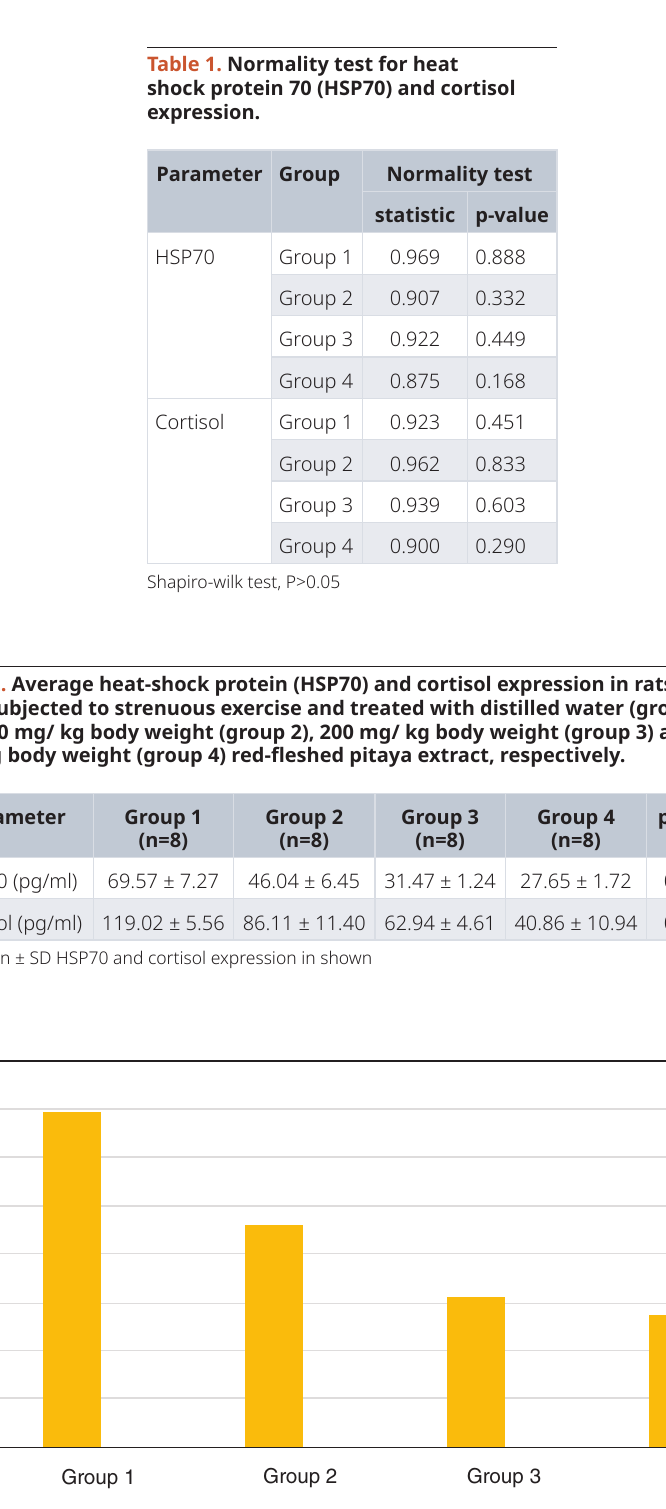
Figure 1. Effect of red-fleshed pitaya extract on HSP70 expression in rats that were given strenuous exercise.